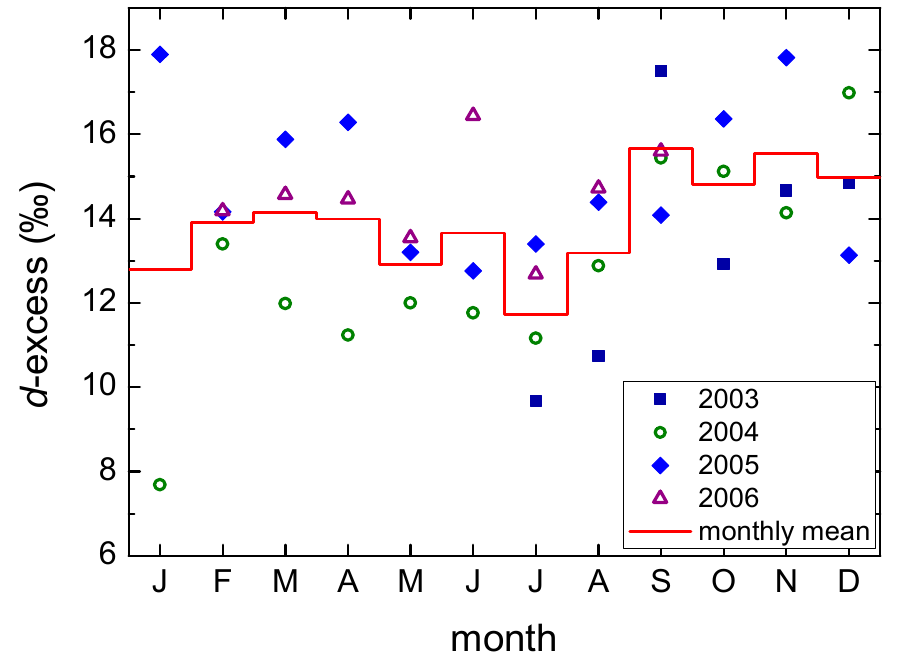
Figure 7. Deuterium-excess values in the precipitation at Plitvice Lakes, 2003–2006 monthly data, and mean monthly values.